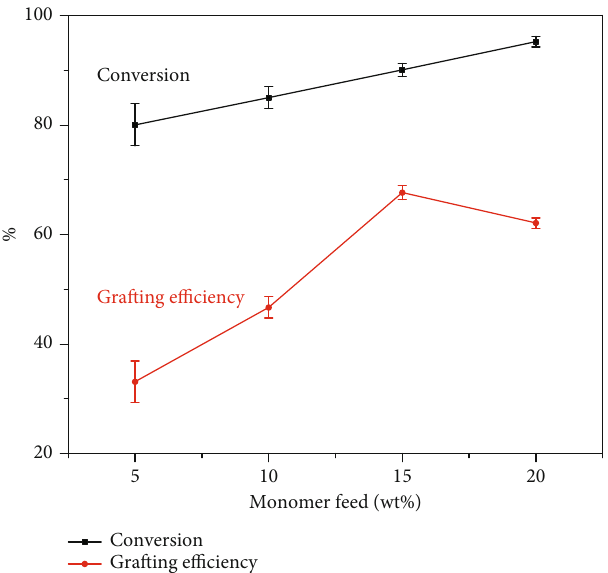
Figure 2: E ff ect of monomer concentration, (wt.% per kg dried rubber), on graft copolymerization when using